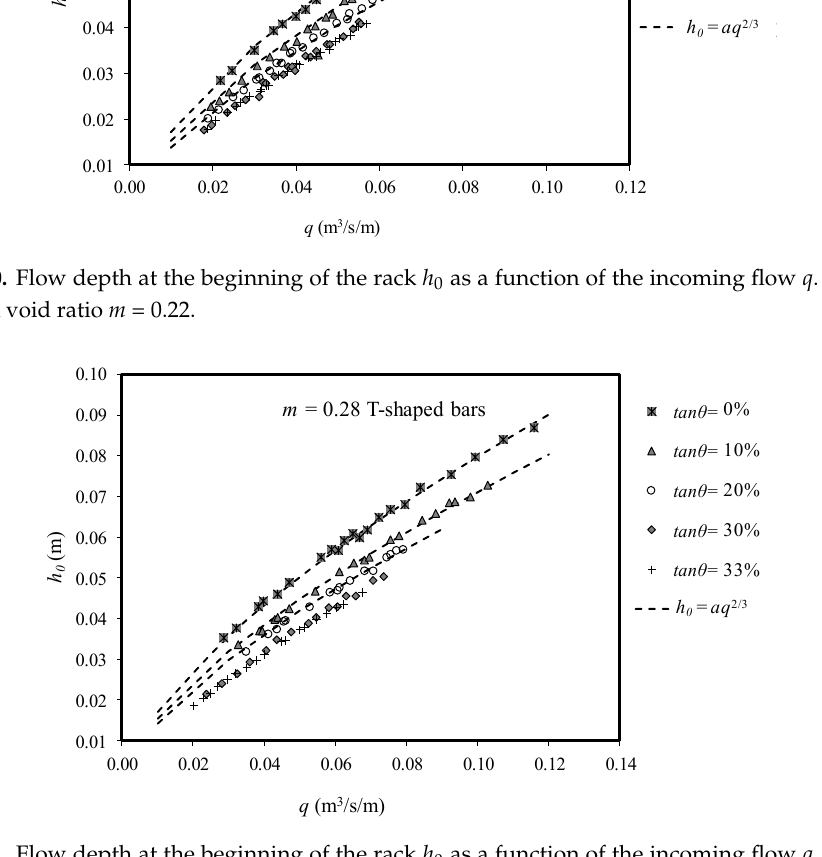
Figure 11. Flow depth at the beginning of the rack h 0 as a function of the incoming flow q . T-shape bars with void ratio m = 0.28. Table 2. Viscosity influence in the flow depth at the beginning of the rack for 30% and 33% longitudinal slopes.